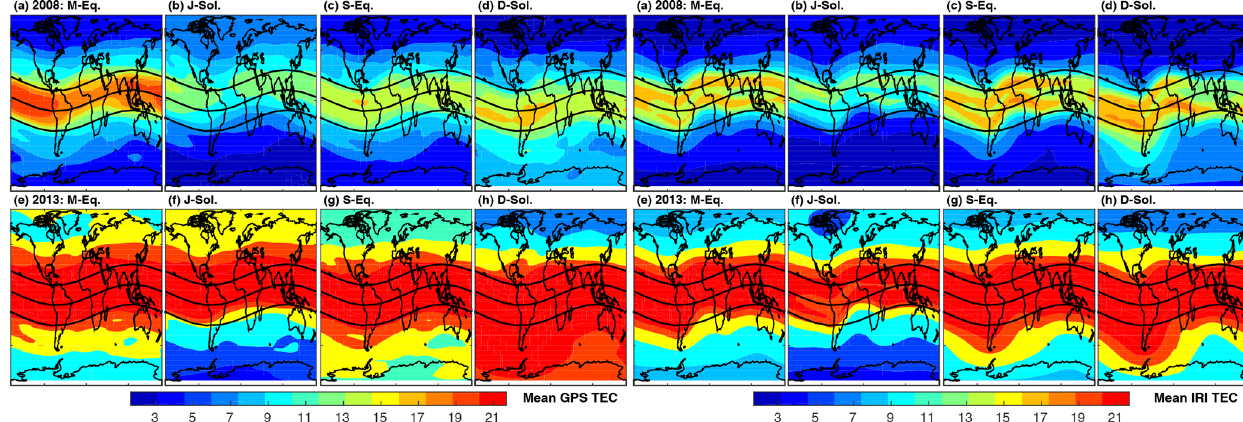
Figure 8. The seasonal mean TEC obtained from the gridded IGS GPS-TEC (the eight left panels) and simulated by IRI-2016 (the eight right panels) for the March equinox (M-Eq), the June solstice (J-Sol), the September equinox (S-Eq), and the December solstice (D-Sol) during the solar minima year 2008 (top row) and the solar maxima year 2013 (bottom row).